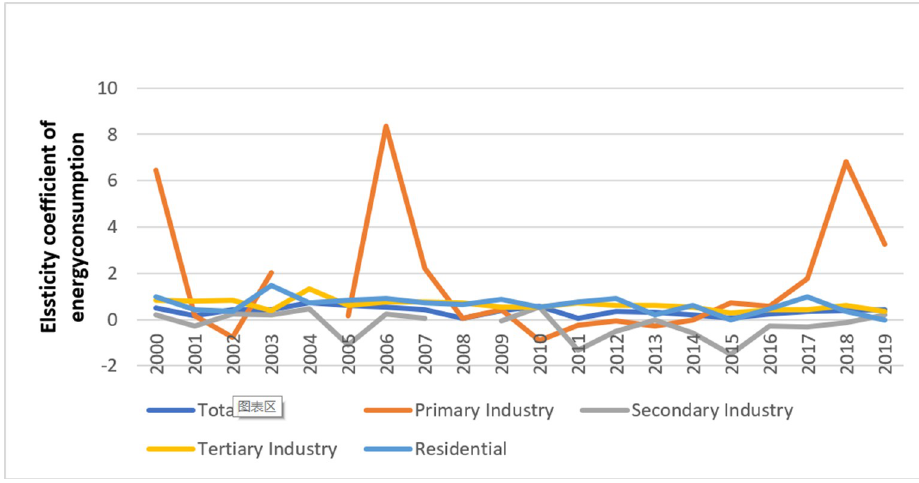
Fig 3. Elasticity coefficient of energy consumption in Beijing from 2000 to 2019.